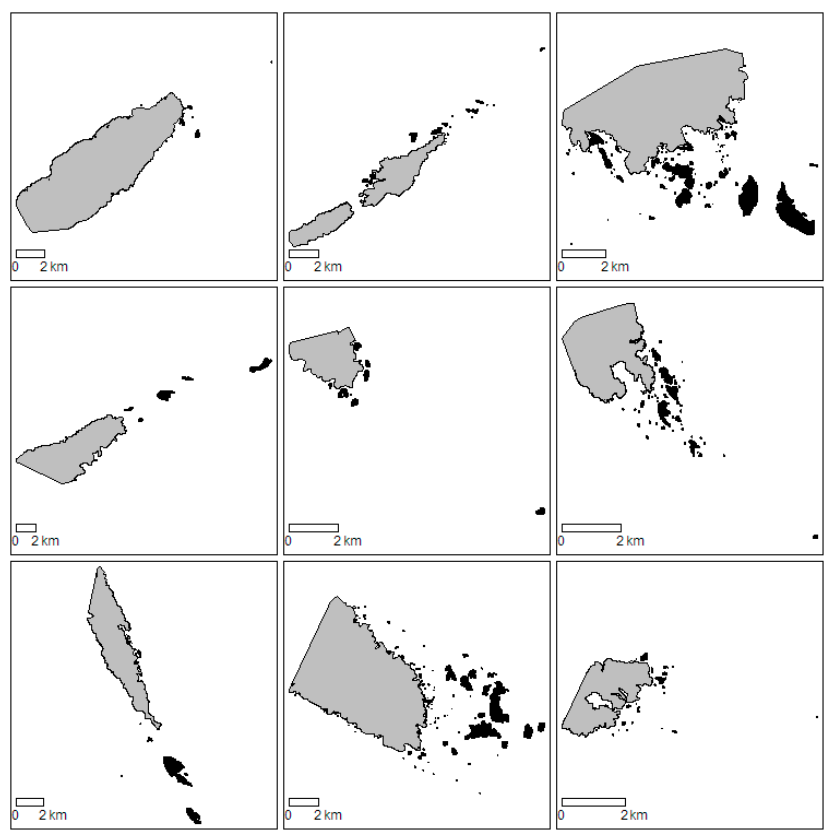
Figure A1. The nine multi-modal distribution fires with the longest maximum spotting distances. Source fire is in grey, spot fires are in black.